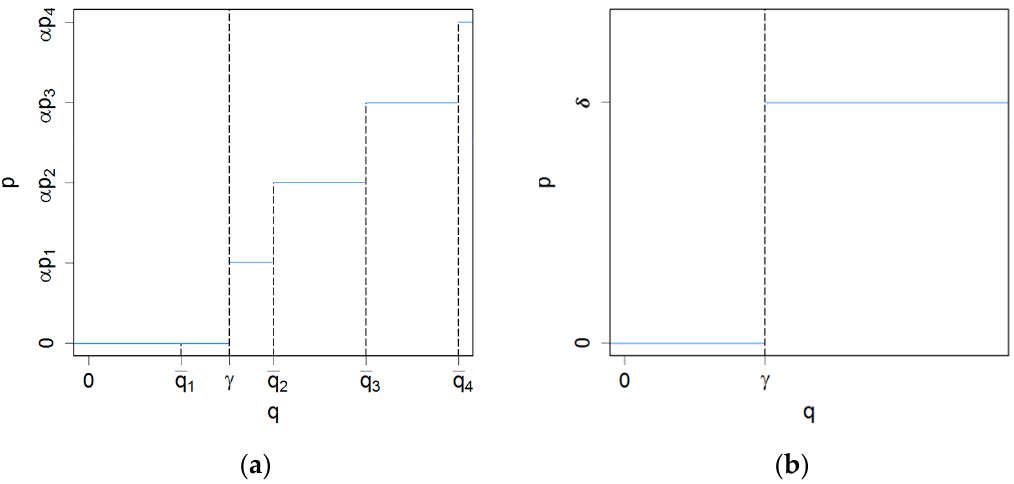
Figure 1. Illustration of the IBT parameters varied in ( a ) simulation experiment 1 and ( b ) simulation experiments 2 and 3. (Block) price ( p , p k ) and quantity ( q , q k ) variables are defined as described in Section 3. α , γ , and δ are parameters used to modify the overall tariff rate level in simulation experiment 1 ( α ) , the quantity of water provided free of charge in all simulation experiments ( γ ) , and the upper block tariff rate in simulation experiments 2 and 3 ( δ ) .